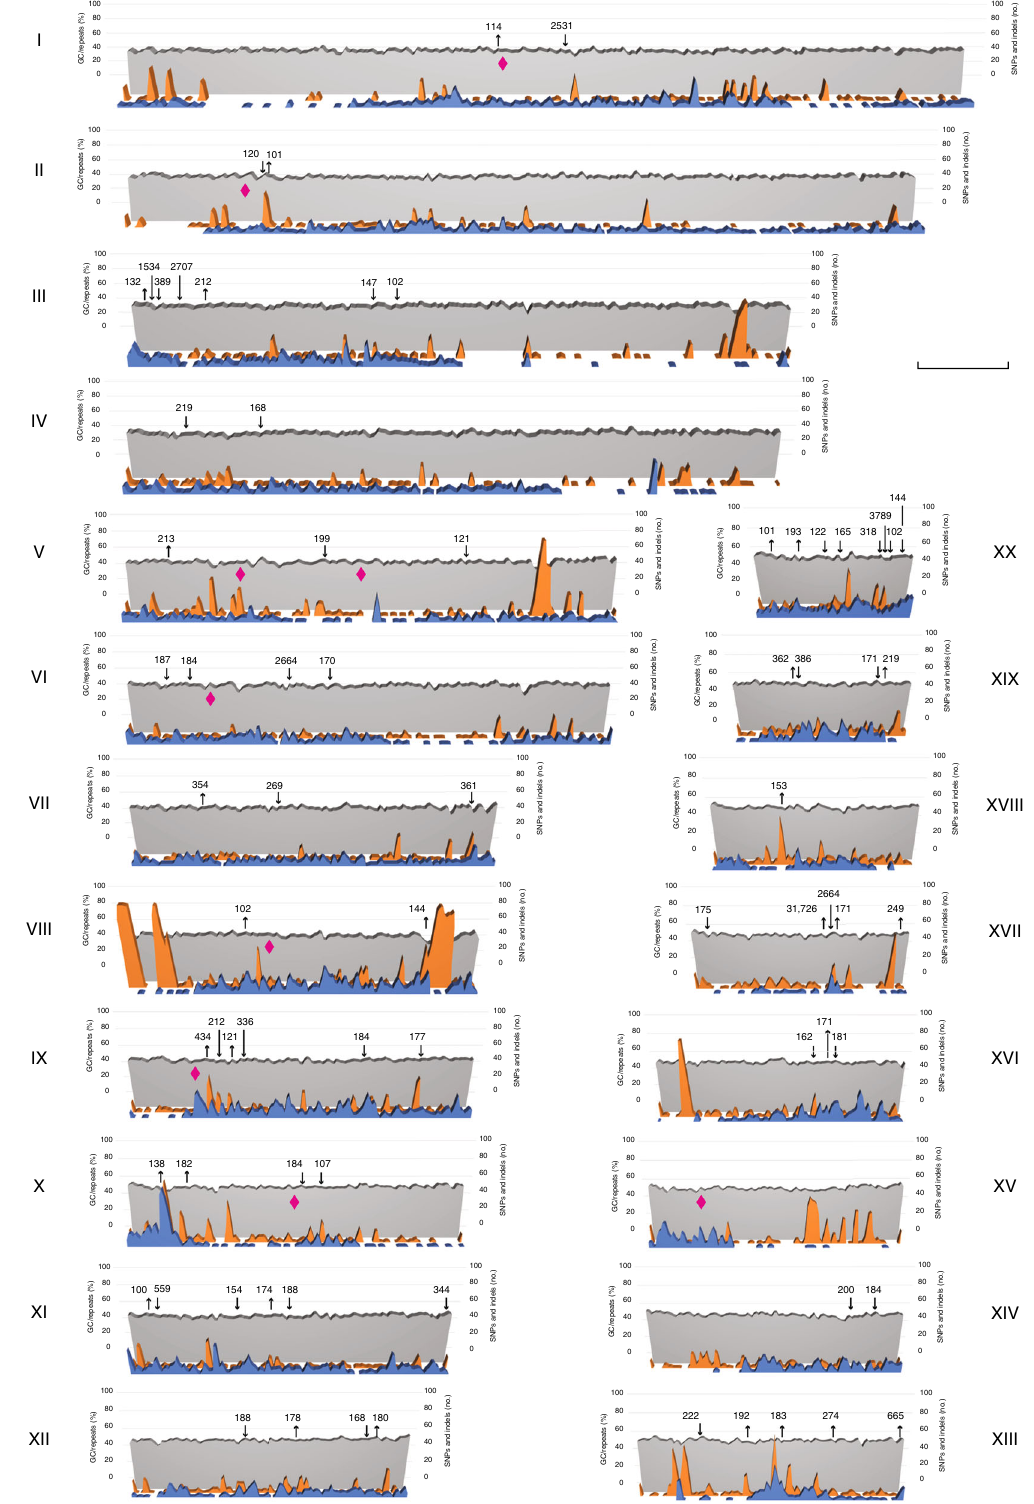
Fig. 3 Variation in GC content and distribution of polymorphic loci and repeats throughout individual Chloropicon chromosomes. The curves shown in blue were obtained by plotting the numbers of SNPs and small indels present in sliding windows of 10,000 nt with a 5000-nt step; dispersed repeats were masked before the identi fi cation of these polymorphisms. The orange curves depict the percentages of nucleotides that are part of repeats in the same windows, while the gray curves depict the percentages of nucleotides with guanine and cytosine bases. The locations of indels ≥ 100 bp are denoted by arrows pointing up (deletions) and down (insertions), and the loci of putative MID genes by magenta diamonds. Chromosomes are labeled with Roman numbers and their lengths are represented to scale on the corresponding x -axis. The scale bar represents 200